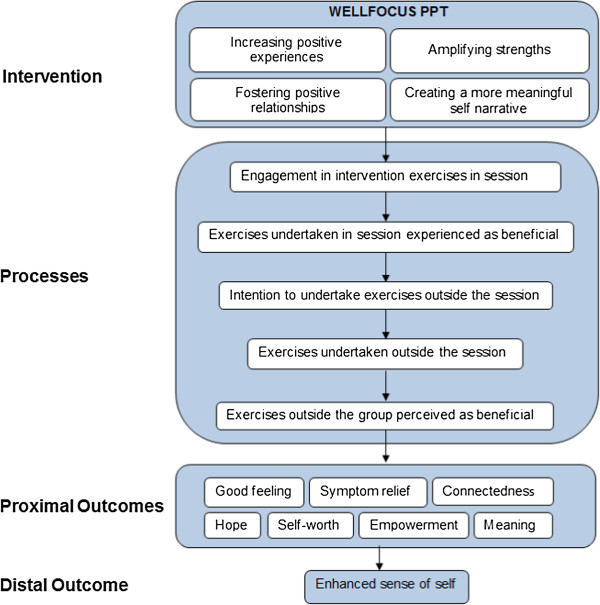
The WELLFOCUS model.